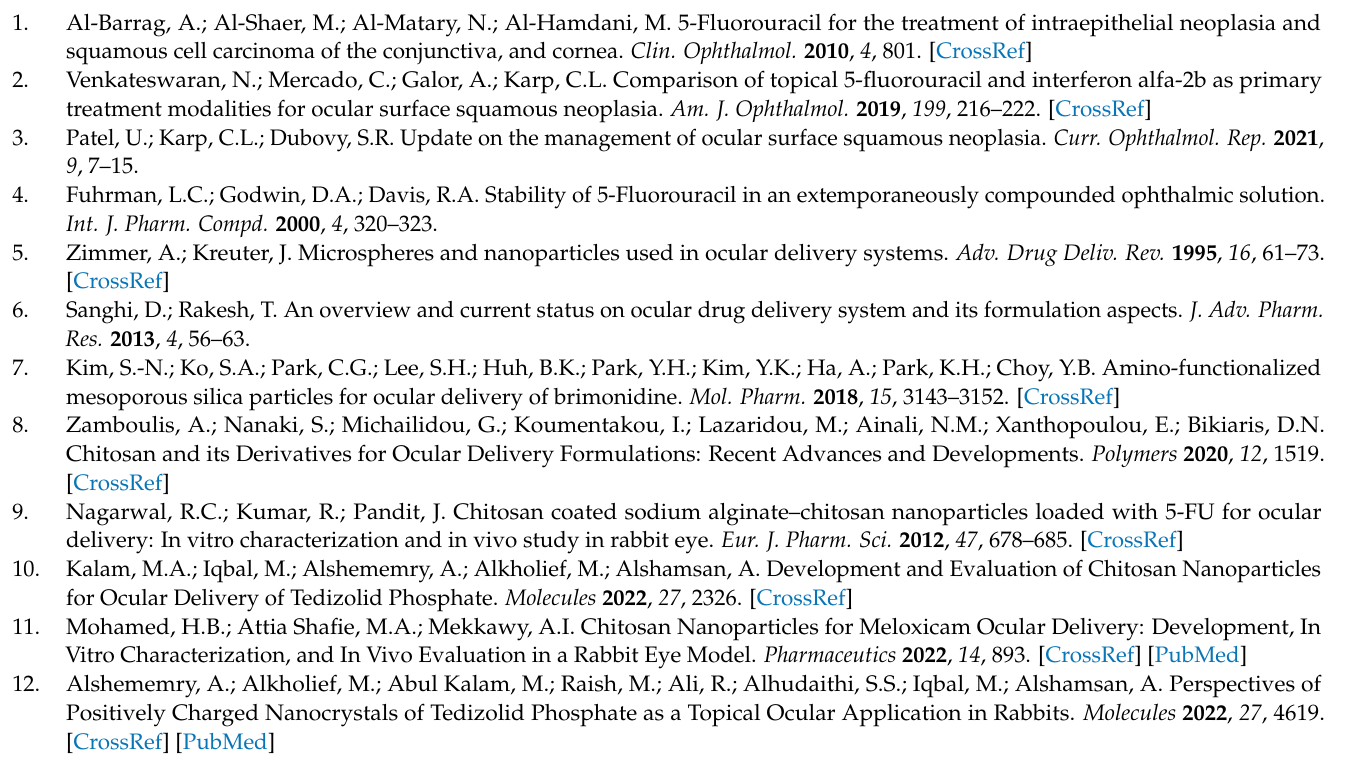
tation test; Table S2: Classification of eye irritation scoring system; Figure S1: Typical chromatograms of the LLOQ, blank AqH, and representative extracted sample from the ocular pharmacokinetic